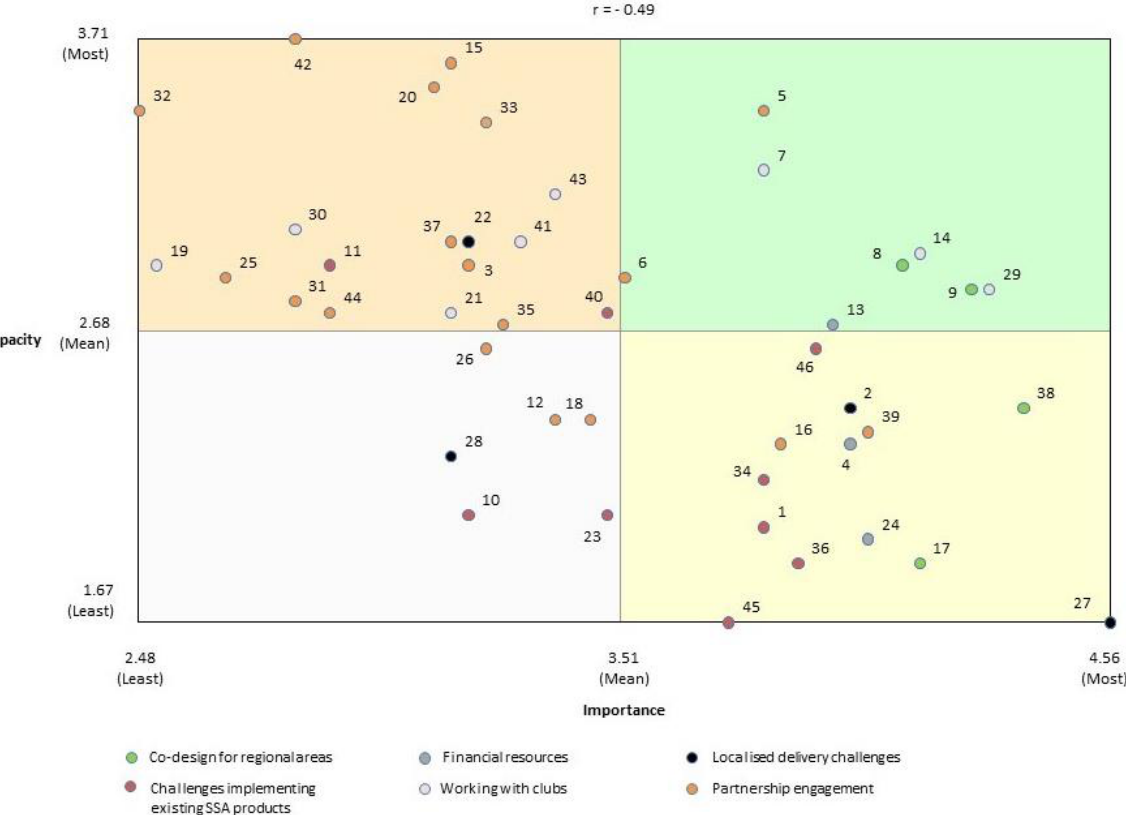
Figure 4. Go-zone graph of challenges to working in partnership to promote physical activity in community sport settings.